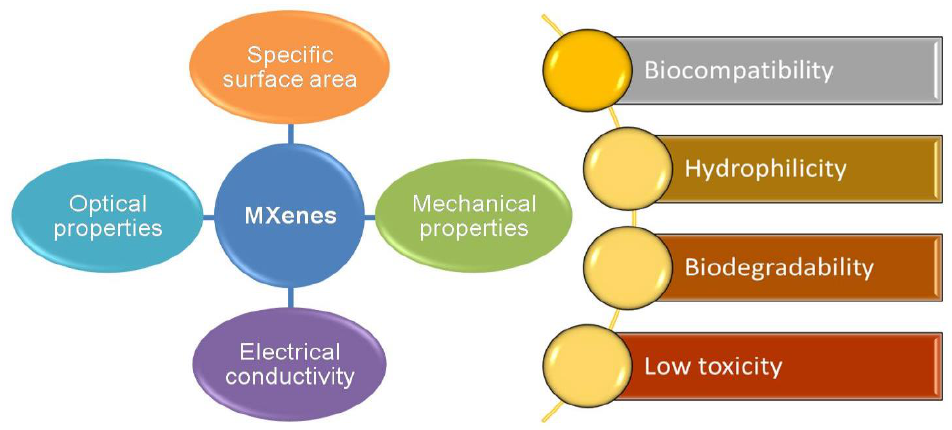
Figure 10. Properties of MXenes and MXene-based materials for biotechnology-related applications.